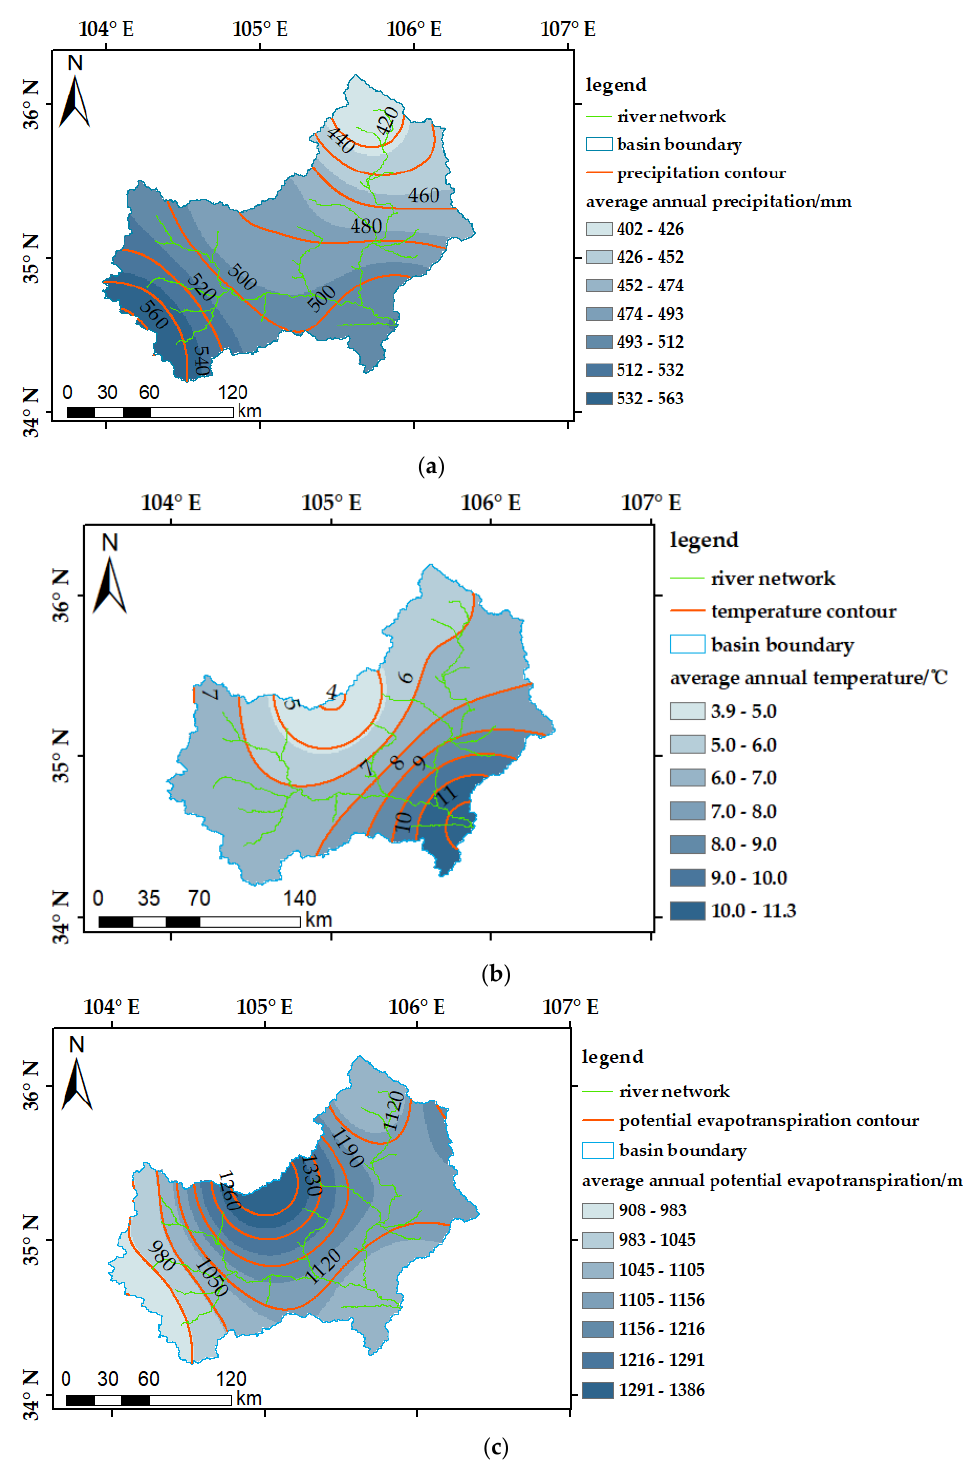
Figure 2. Spatial distribution map of annual average precipitation, temperature and potential evapotranspiration. ( a ) precipitation, ( b ) temperature, ( c ) potential evapotranspiration.